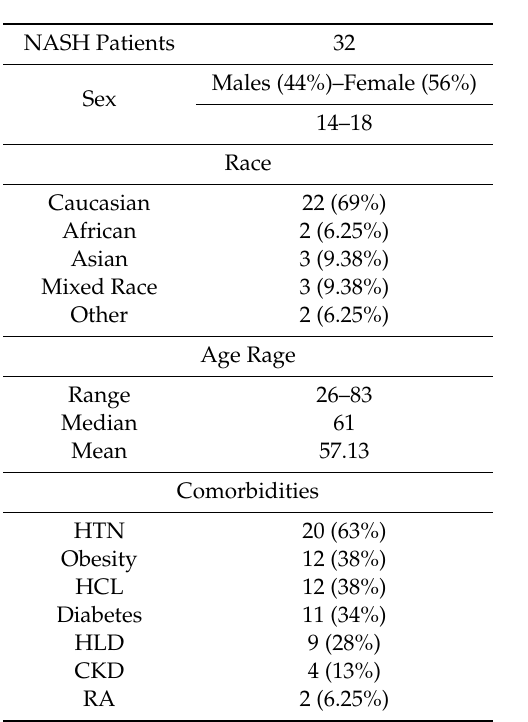
Table 5. Patients with